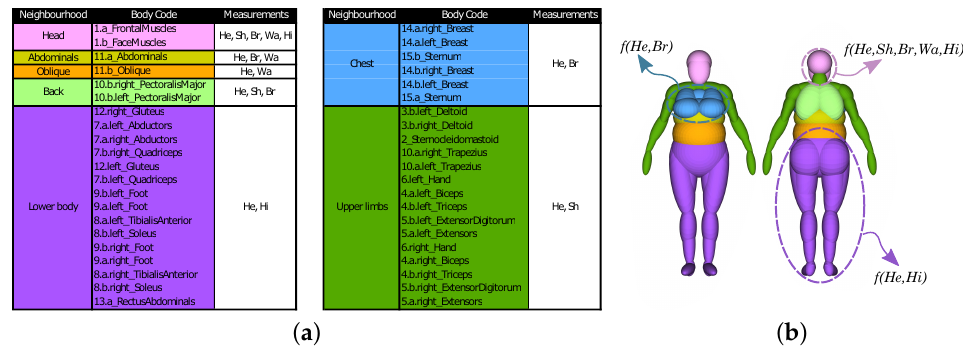
Figure 16. Body subsets of ellipsoids for segmented interpolation scheme. Each subset is inter- polated with different subsets of the input measurements Me . ( a ) Measurement dependency for body neighborhoods (subsets of ellipsoids). ( b ) Example of subsets of ellipsoids influenced by different